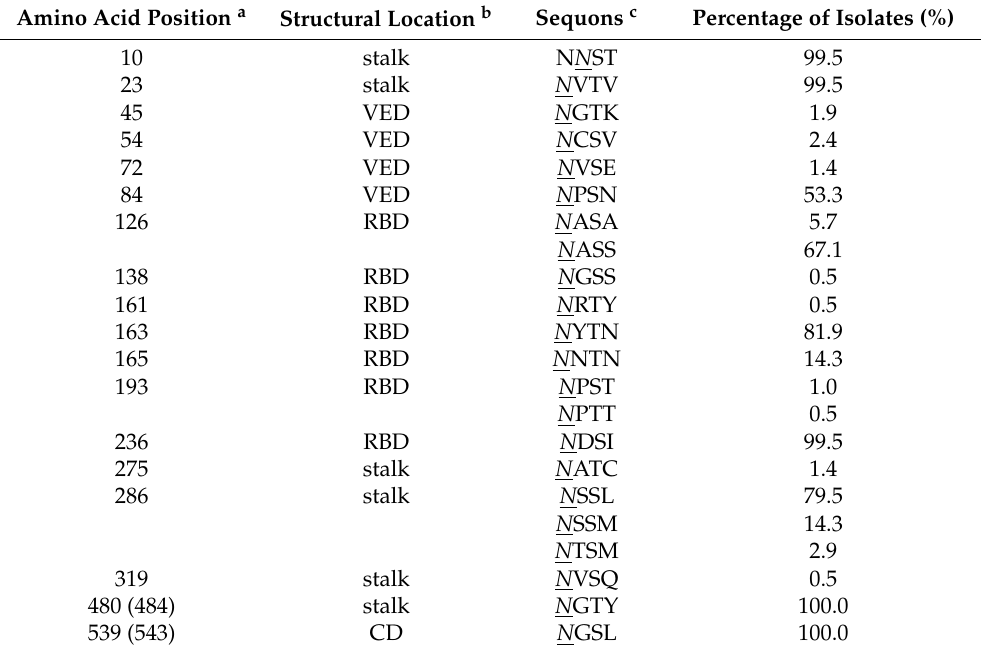
Table 3. Potential N-glycosylation sites identified in HA protein of 210 Mexican H5N2 AIVs. Amino Acid Position a Structural Location